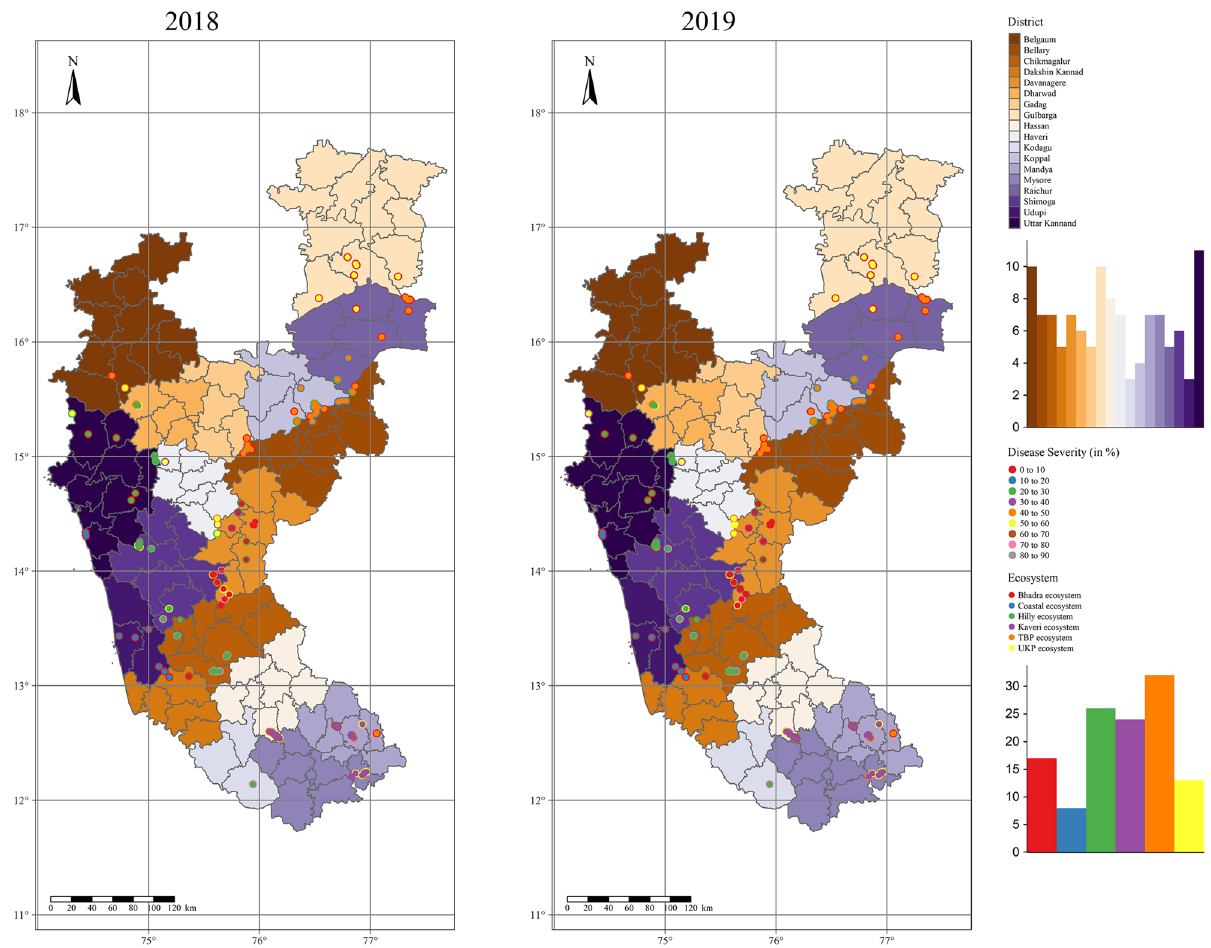
Figure 2. Distribution map indicating the sampling sites and the severity of rice blast disease in different rice ecosystems of Karnataka during 2018 and 2019. The maps were created using R software (version Surface interpolation to the explicit spatial distribution. IDW interpolation approach. Inverse distance weighted (IDW) interpolation identifies the cell values using a linearly weighted combination of a set of sample points. Contour maps created using the IDW procedure exhibited the RBD distribution pattern in different rice ecosystems of Karnataka (Fig. 6). During both the years of evaluation, the Hilly ecosystem, middle and southern parts of Karnataka has posed a potential risk to RBD with higher disease proportions (> 70%), with focal points at Chikmagalur, Kodagu, and Shivamogga districts followed by Kaveri and Bhadra ecosystems with 50–60 percent severity. Upper Krishna Project (0–10%) and coastal (0–10%) ecosystems were less disease-prone areas for RBD with relatively reduced disease indices. However, the TBP ecosystem had moderate disease sever- ity (20–30%). It is evident from the maps of both years that the disease hot spots are majorly in the middle and Southern Karnataka, and cold spots are in Coastal and Northern Karnataka. The IDW results were further validated by a scatter plot for predicted severity against observed severity during 2018 and 2019 (Fig. 7). From the plot, the predicted and observed severity almost lies along the line, excluding the errors during both years. The plot values representing the RBD during 2018 and 2019 exhibited a similar severity with RMSE values of 13.37 and 13.11, respectively.